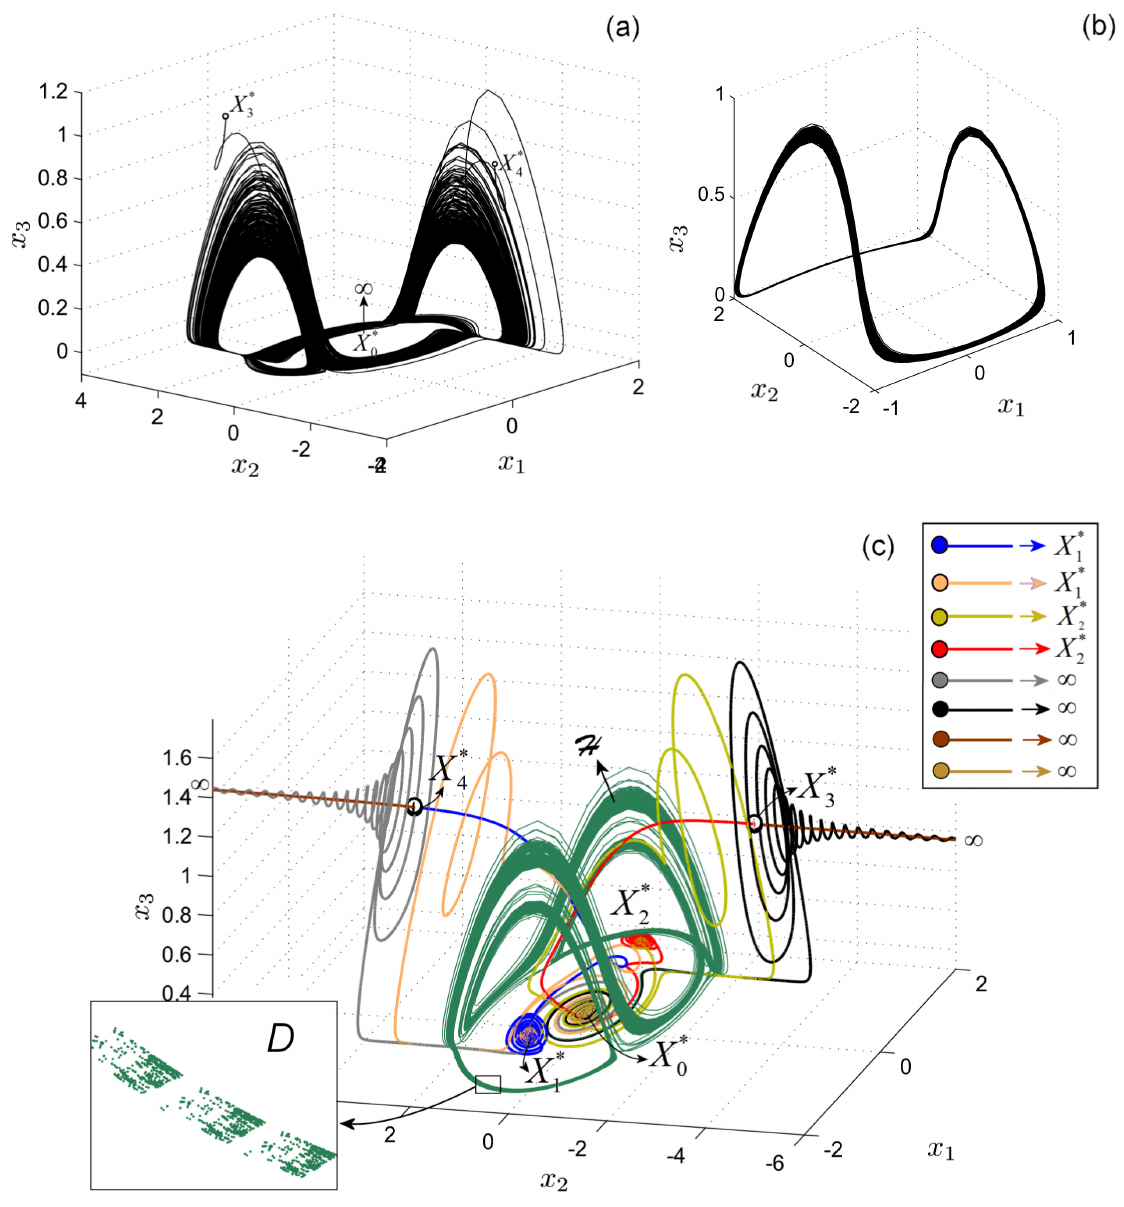
Figure 2. Attractors of the RF system. ( a ) SECA for b = 0.98. Trajectories from unstable equilibria X ∗ are attracted by the 3,4 SECA, while trajectories starting from X ∗ tend to infinity; ( b ) quasiperiodic attractor for b = 0.25675 after the first transients 0 are removed; ( c ) HSNA for b = 0.2875. Beside the attractor H (green plot), trajectories are presented from unstable equilibria X ∗ and X ∗ , which are attracted either by the stable equilibria X ∗ or diverge to infinity (see the legend). The dotted plot in 0 3,4 1,2 the zoomed image D reflects the fractal autosimilariity characteristic of H